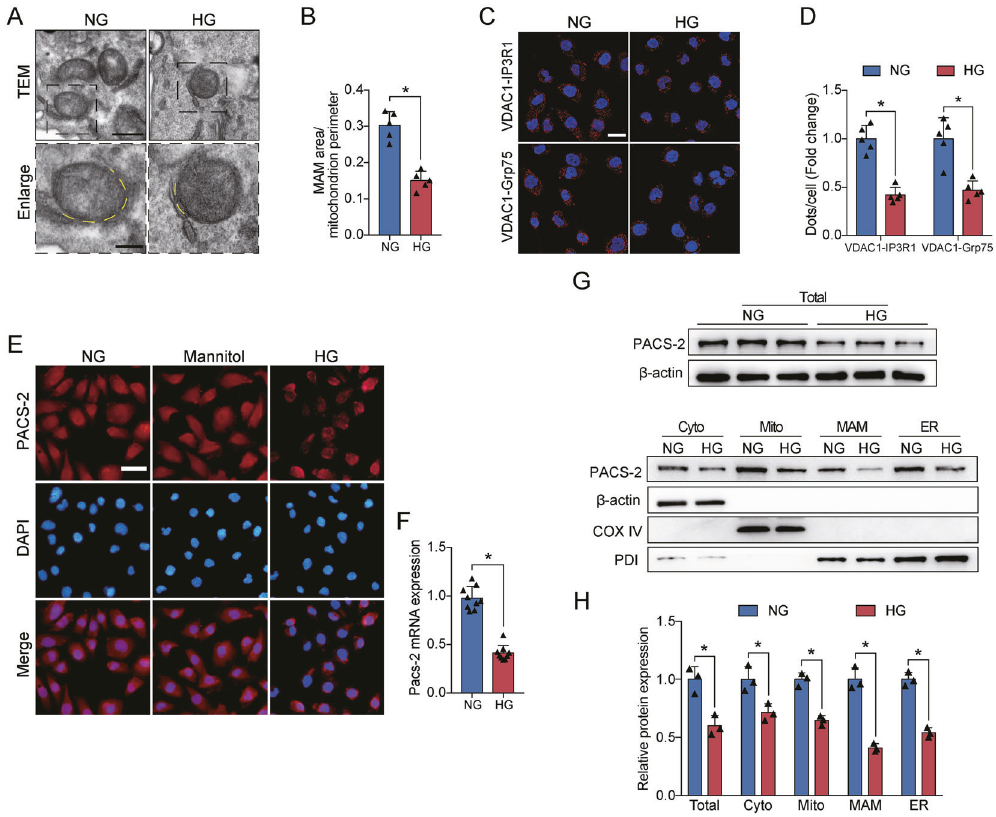
Fig. 6 HG altered MAM integrity and PACS-2 expression in vitro. A Representative TEM images showing the MAM area in HK-2 cells. Yellow lines indicate the MAM interface. Scale bars = 500 nm, inset scale bar = 200 nm. B Quantitative analysis of MAM area normalized to mitochondrion perimeter in A . n = 5. C Representative in situ PLA images showing the VDAC1/IP3R1 or VDAC1/Grp75 complexes in HK-2 cells. Scale bars = 50 μ m. D Quantitative analysis of in situ PLA dots in D . n = 5. E Immuno fl uorescence staining of PACS-2 in HK-2 cells. Scale bar = 50 μ m. F RT-PCR analysis of Pacs-2 mRNA levels in HK-2 cells. n = 9. G Western blot bands of PACS-2 proteins in total lysates and subcellular fractions isolated from HK-2 cells. H Quantitative analysis of PACS-2 protein levels in G . n = 3. All data are expressed as mean ± SD. * P <